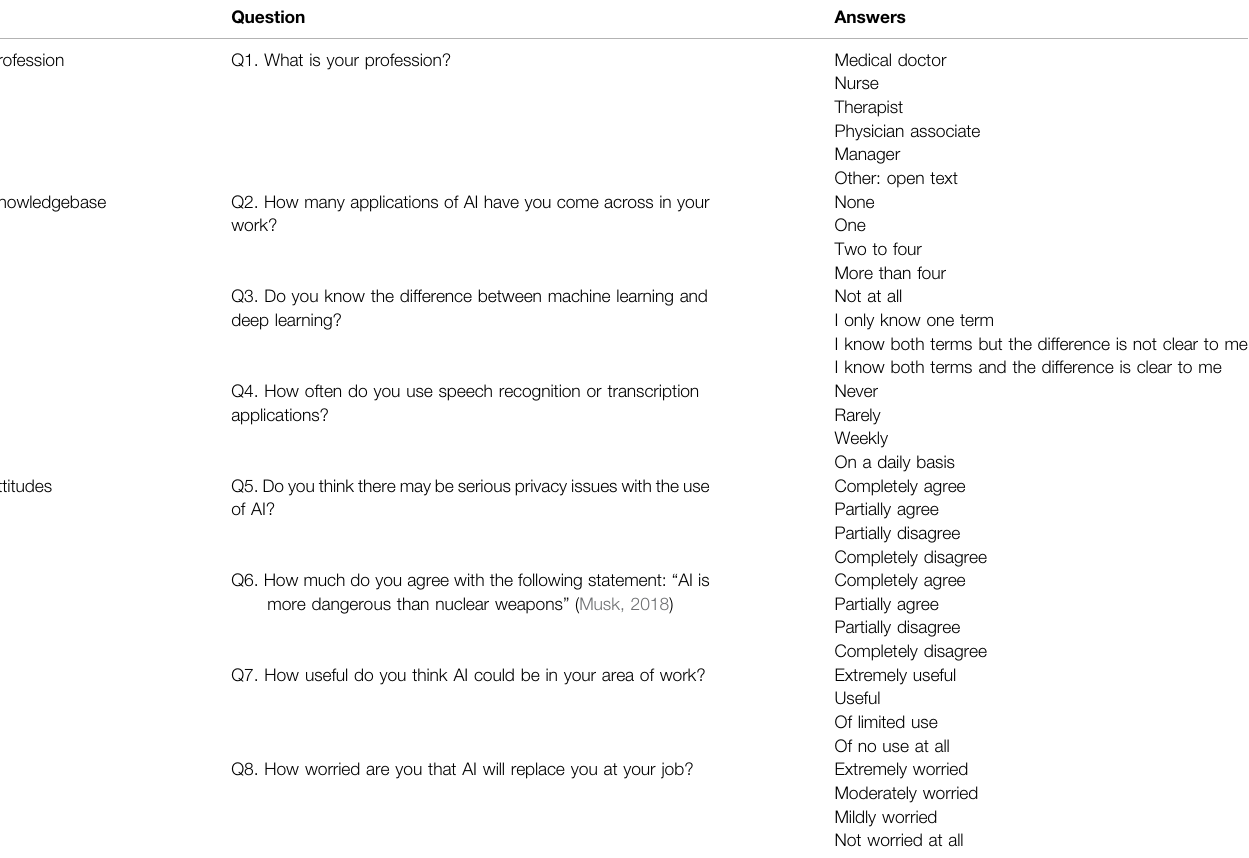
TABLE 1 | Online questionnaire on the perceptions of AI within health professionals. The survey was divided into three sections: Profession, knowledgebase, and Attitudes. Question